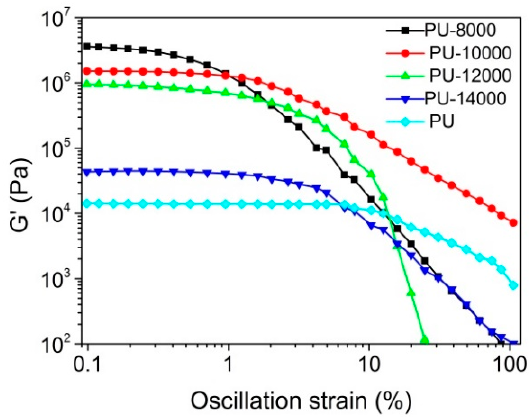
Figure 6. Dynamic strain sweep of: G (cid:48) for neat PU, PU-8000, PU-10000, PU-12000 and